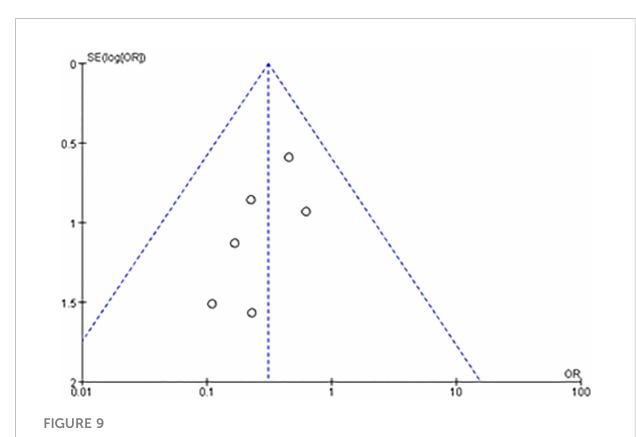
FIGURE 9 Funnel plot evaluating publication bias for technical